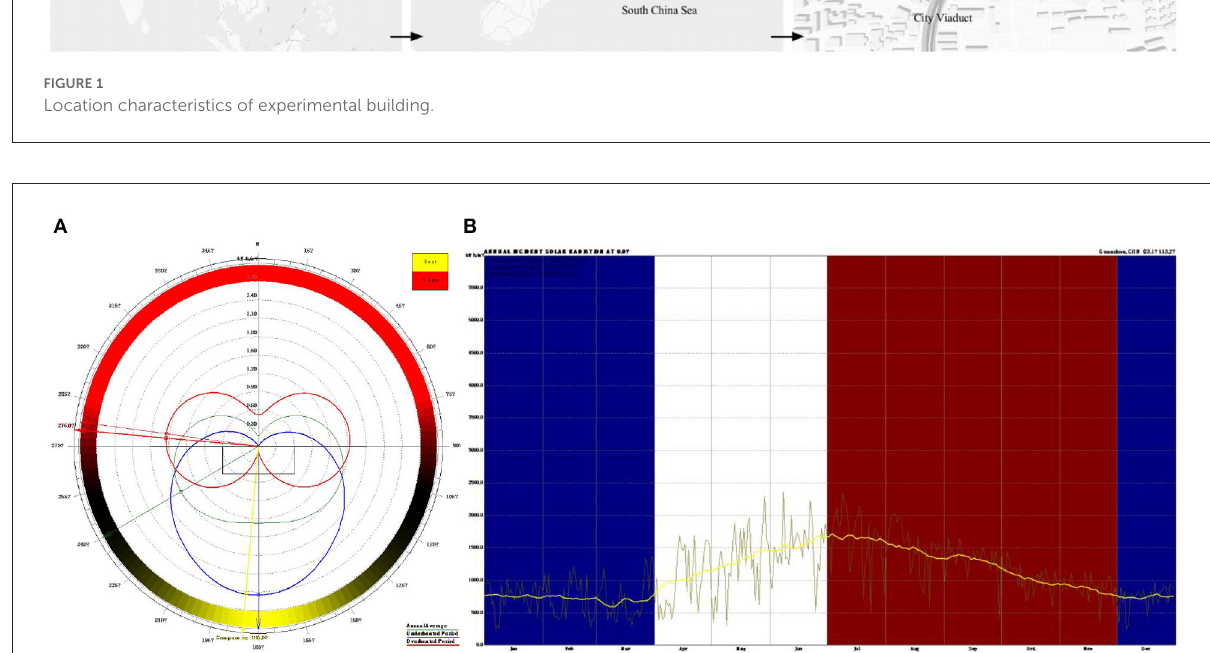
FIGURE2 Analysis results obtained by the weather tool. (A) Solar radiation; (B) The overheating period and the supercooling